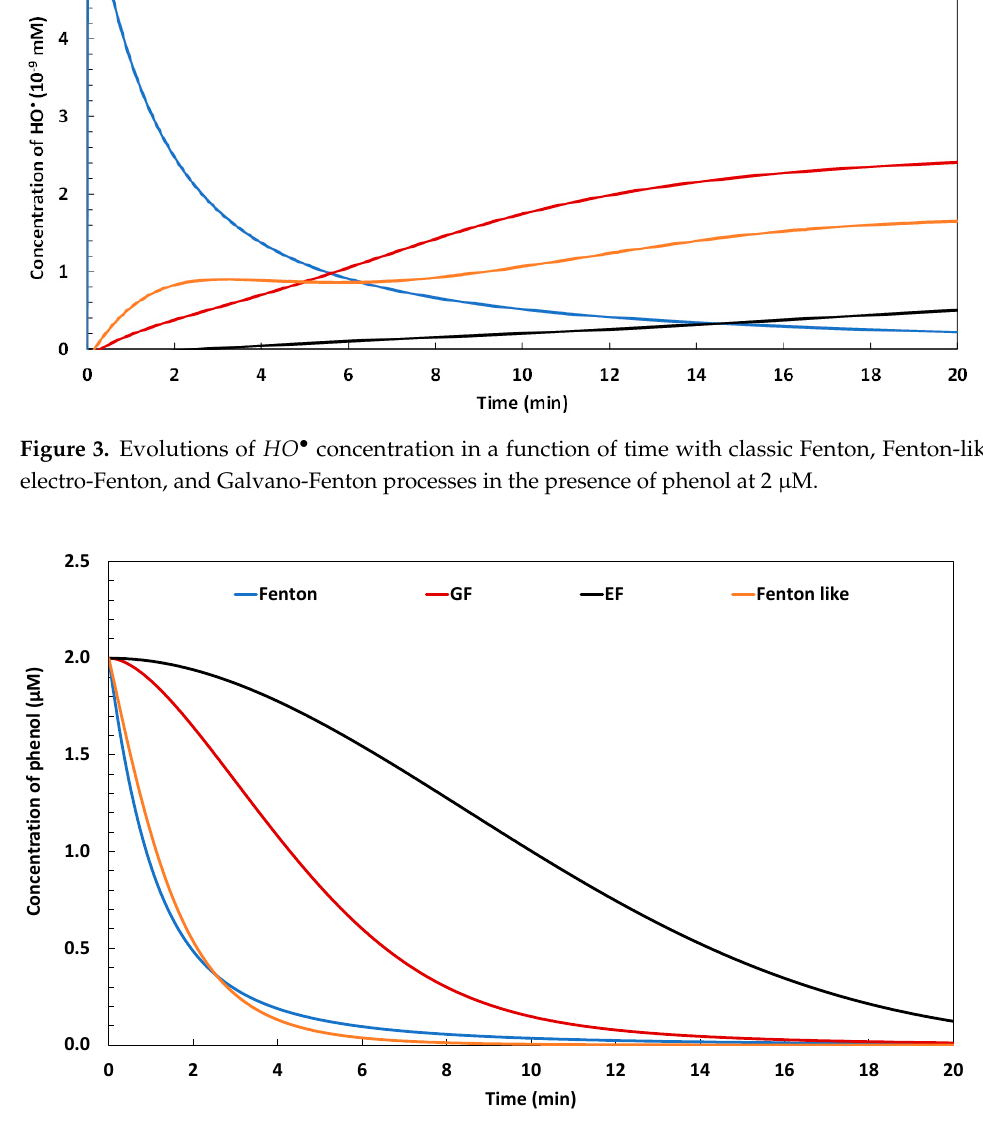
Figure 4. Evolution of the concentration of phenol in function of time with classic Fenton, Fenton-like, electro-Fenton, and Galvano-Fenton processes with an initial phenol concentration of 2 µM.